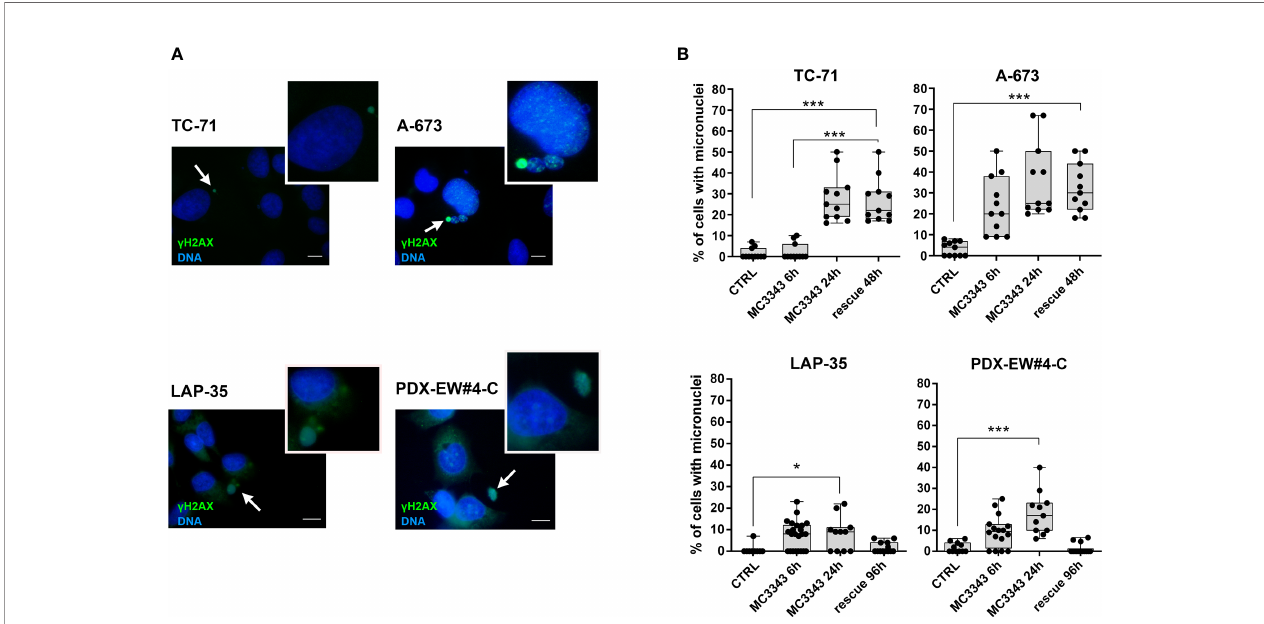
FIGURE 4 | MC3343 treatment induces micronuclei formation. (A) Representative images of g H2AX (green) and DNA (Hoechst 33258, blue) staining of EWS cells following treatment with MC3343. The white arrows indicate micronuclei that contains DSBs (as indicated by DNA and g H2AX double-staining). Scale bars, 10 µm. (B) Percentage of micronuclei in EWS cells treated with MC3343 at the indicated times and after 48-96h of rescue with drug-free medium replacement. Data are presented as the mean percentage of micro-nucleated cells quanti fi ed from at least 20 random fi elds (mean ± SE; *p < 0.05, ***p < 0.001, one-way ANOVA